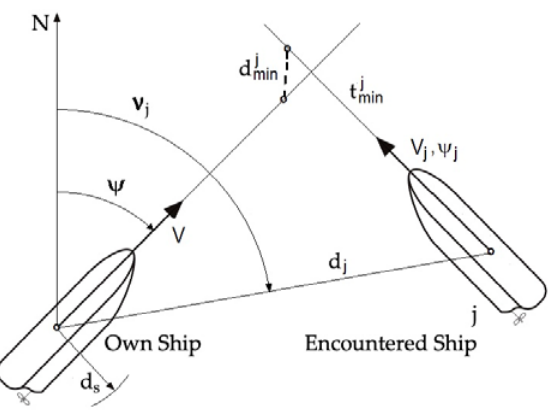
Figure 2. State variables x 0 (d jmin , t jmin ), x j (d j , ν j ) and control variables u 0 (V, ψ ), u j (V j , ψ j ) describing the process of moving ships.